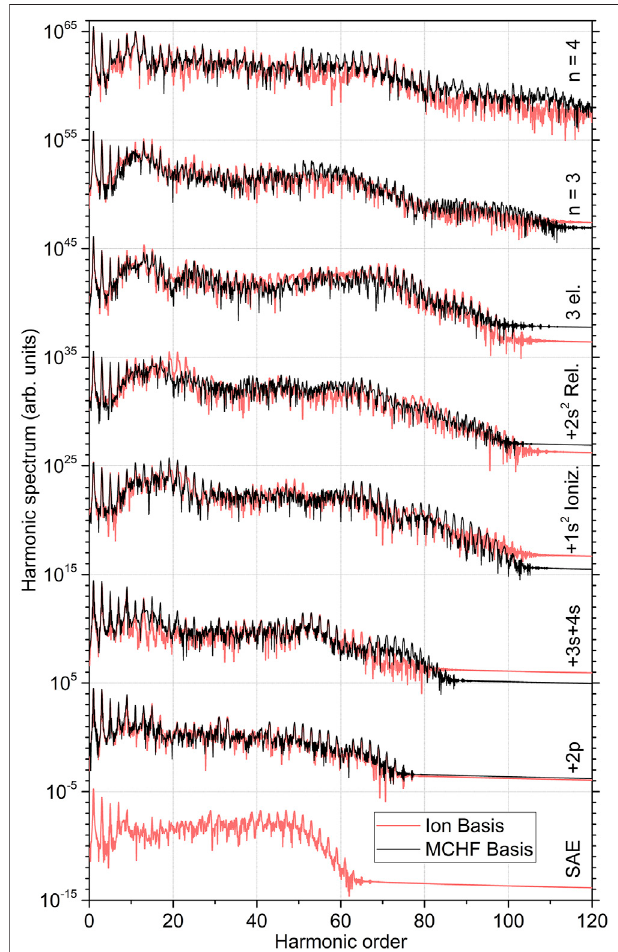
FIGURE 3 | Comparison of the high-order harmonic generation spectra of beryllium atom computed using the ionic and MCHF basis sets in different level of systematically improving approximations (indicated at the right-hand vertical axis, see also captions of Figures 1 , 2 for details on the data representation). The fi ve lowermost spectra obtained in the ionic basis set correspond to those depicted Figure 1 , while the three uppermost ones to the three uppermost spectra shown in Figure 2